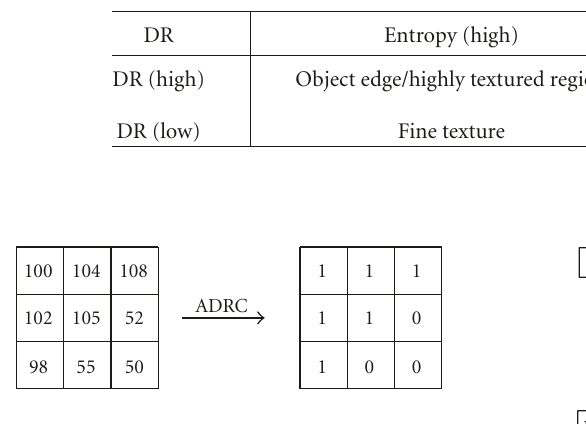
Table 1: Coarse classification of a region.